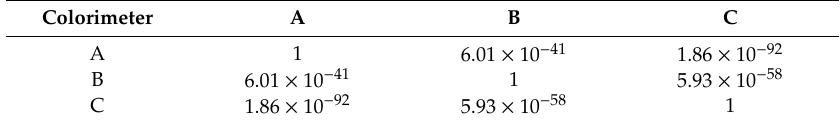
Table 4. ANOVA test ( p -value) of colorimeter data for study areas (age categories) A, B,